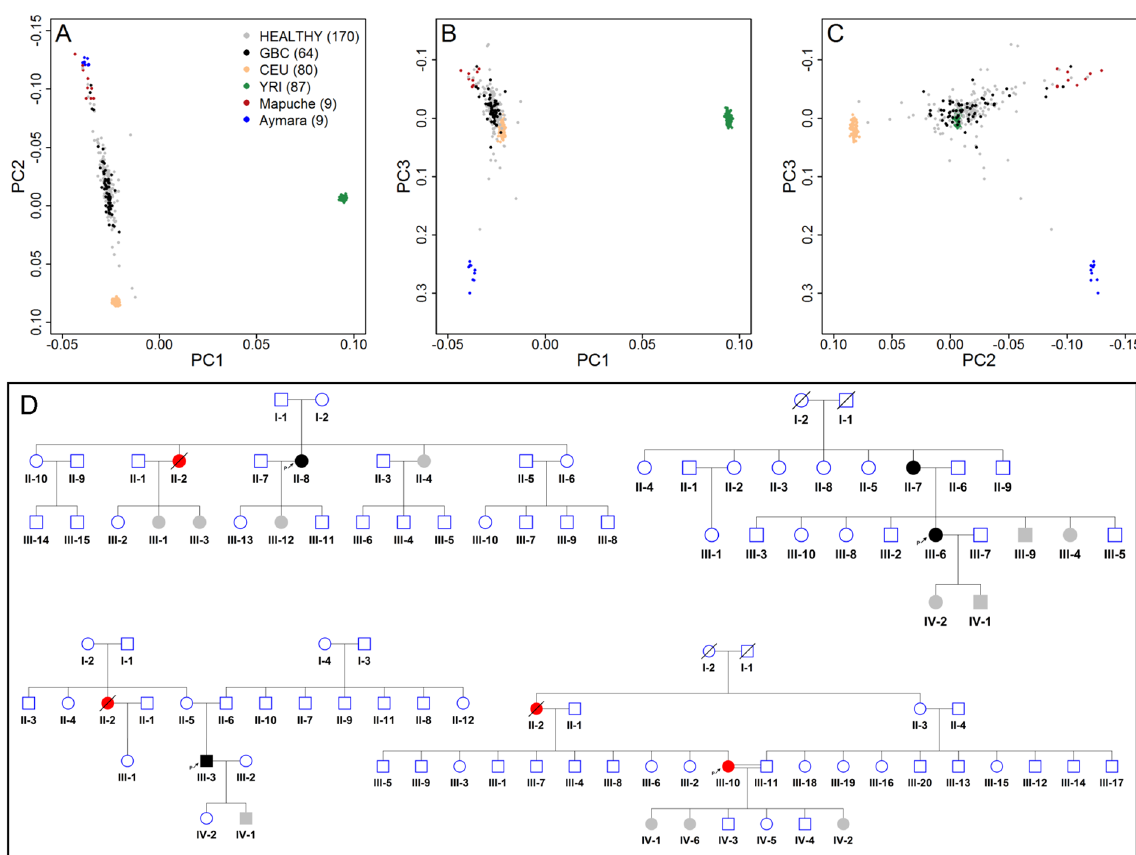
Fig 4. Genetic principal component analysesof individuals used in the validation study to investigate the relationship between Mapuche proportions and gallbladder cancer risk, using Mapuche and Aymara individuals as surrogates of the two largest indigenous peoples in Chile (panels A-C). Gallbladder cancer cases are represented by black dots and unaffected subjectsby grey dots. Fig 4D represents the pedigreesof the four families includedin the validationstudy (Gallbladder cancer cases genotyped in the study are representedby black dots, unaffectedgenotyped subjects by grey dots, non-genotypedgallbladder cancer cases by red dots and unaffectednon-genotyped subjects by empty